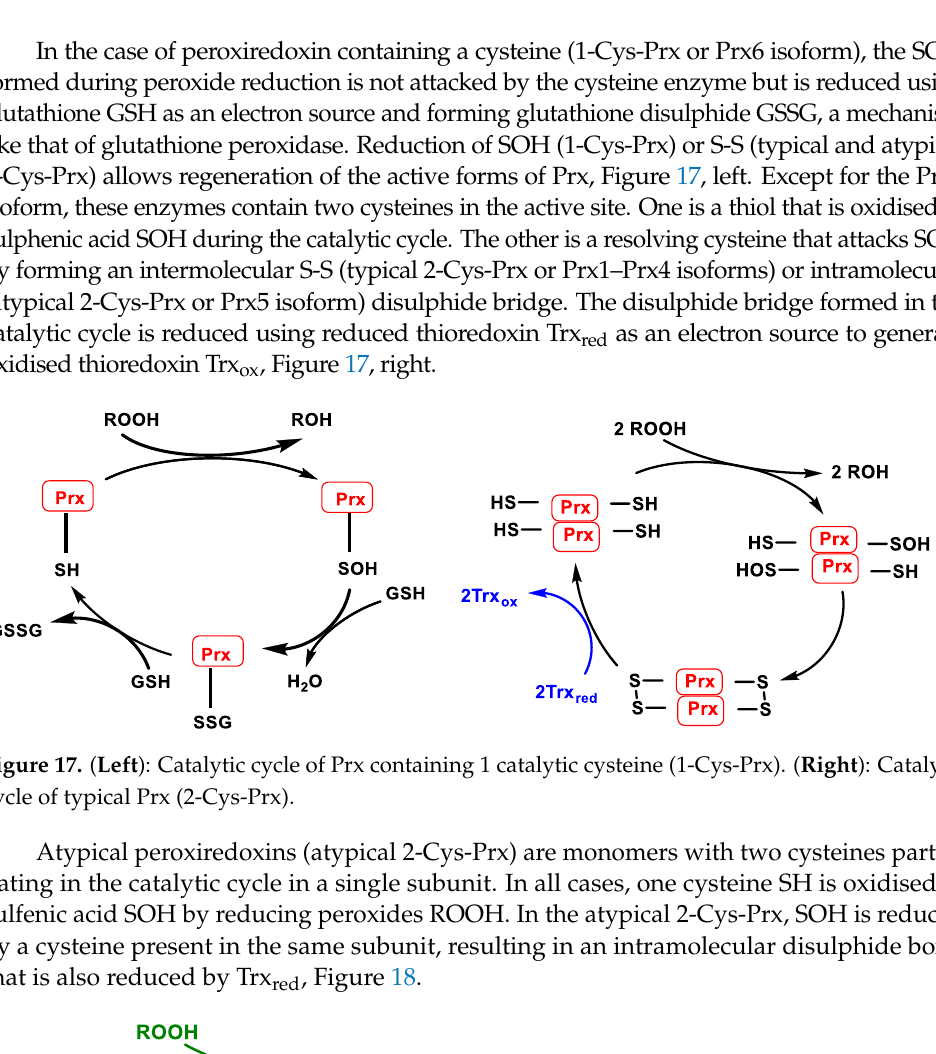
Figure 19. Thioredoxin reductase catalytic cycle (TrxR). When used as an electron source in the catalytic peroxiredoxin cycle, thioredoxin Trx meets the thiol group SH of its two cysteines in disulphide form S-S. TrxR, which has a selenocysteine in selenol form SeSH and a SH at its catalytic site, performs the S-S reduc- tion of Trx, forming an intermolecular sulphur-selenium bridge S-Se. This bridge is then reduced, creating an intramolecular S-Se bridge in TrxR and releasing the Trx in reduced form. TrxR regenerates into its reduced form using NAPDH as an electron source [47]. 3.4. Hypochlorous Acid Formation (HOCl). HOCl biologically falls into a group of small molecules known as reactive species RS synthesised by cells of the immune system (neutrophils and macrophages). HOCl plays a dual role, performing a bactericidal function against infections and, on the other hand, it can cause damage to the molecular structures and cells of the host organism. HOCl is a powerful antimicrobial oxidant, capable of modifying DNA, lipids and lipoproteins, re- acting rapidly with the sulphur atom present in thiols and thioethers (cysteine and methi- onine) [48]. Excessive generation of HOCl can cause tissue damage and is thought to be important in the progression of a number of diseases including atherosclerosis, chronic inflammation and some cancers [49]. Myeloperoxidase is the most abundant protein in neutrophils and is the only perox- idase that catalyses the conversion of hydrogen peroxide and chloride to hypochlorous acid [50], Figure 20.